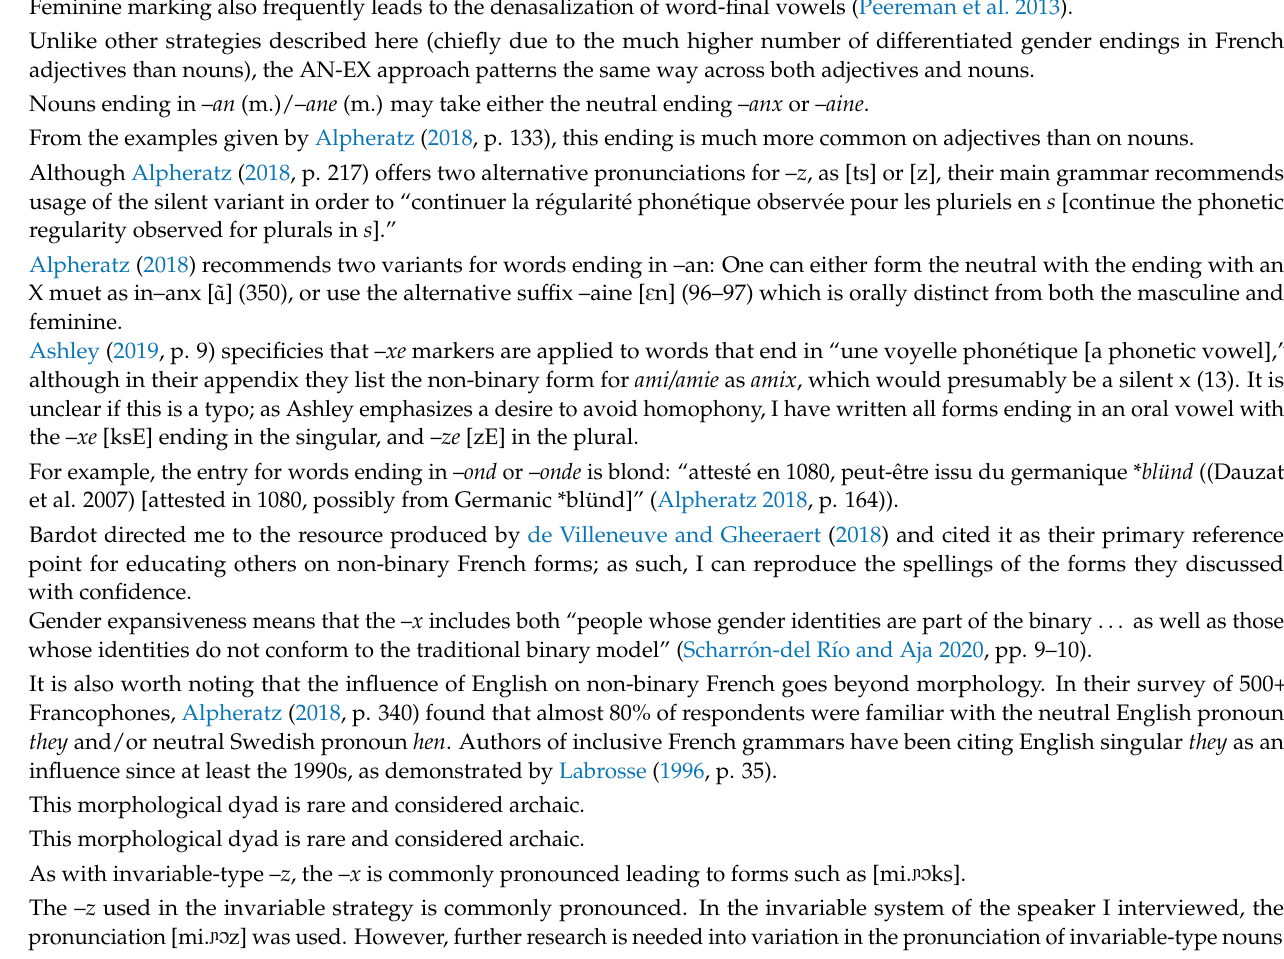
Table 2. Masculine and Feminine Homophones. Feminine Masculine IPA